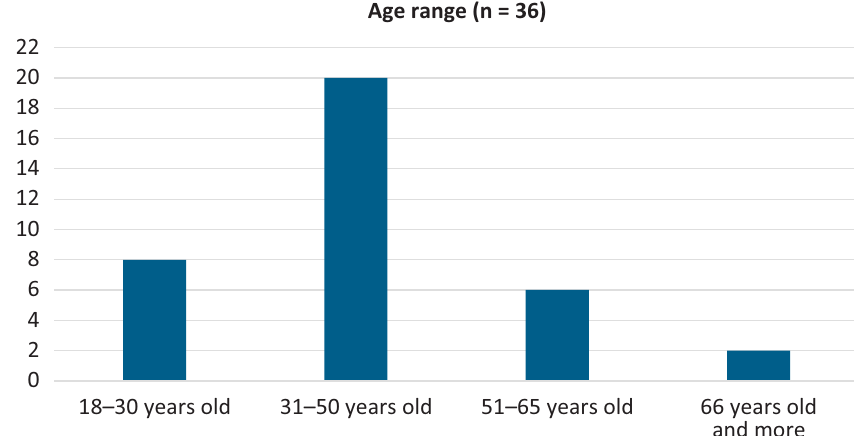
Figure 1. Age range of the workshop participants.